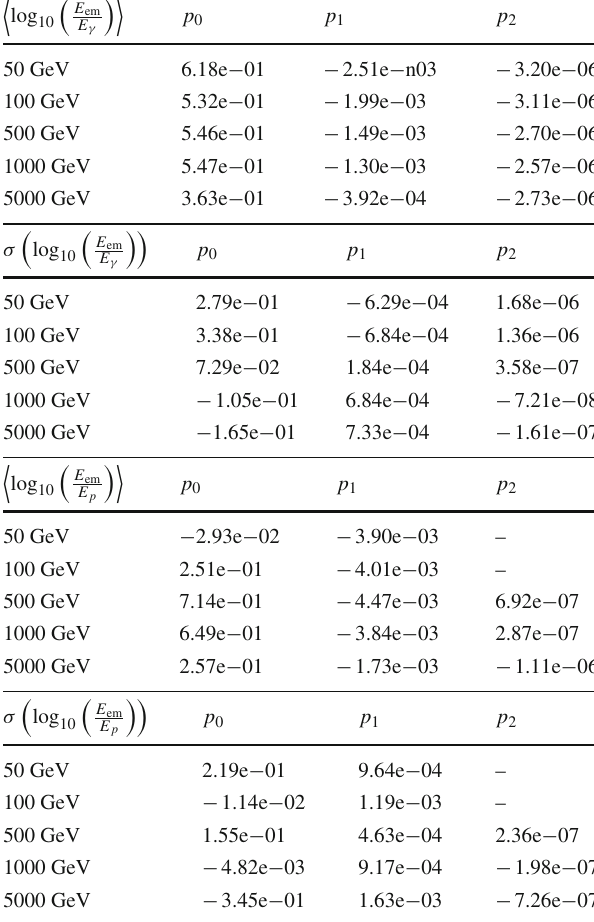
Table1 Fitresultstoparameterisethedistributionsof E em asafunction slant depth. Listed are the parameters from a polynomial fit f ( X sl ) =